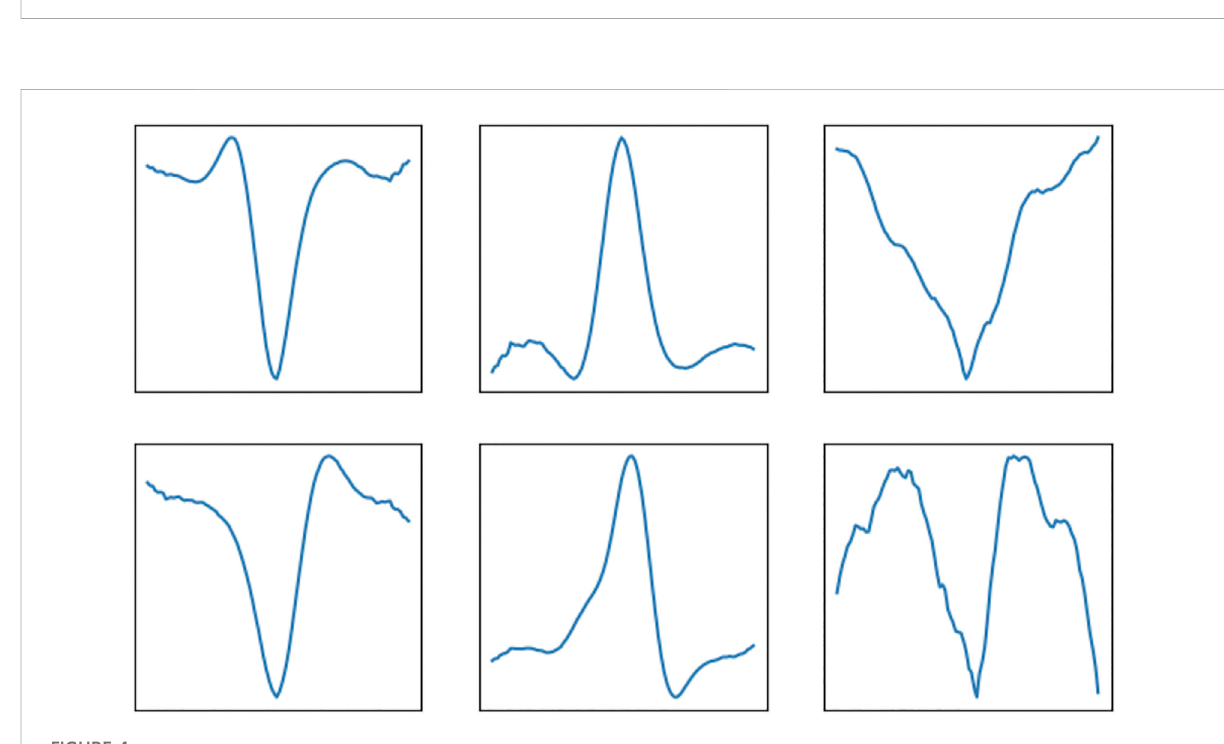
Frontiers in Signal